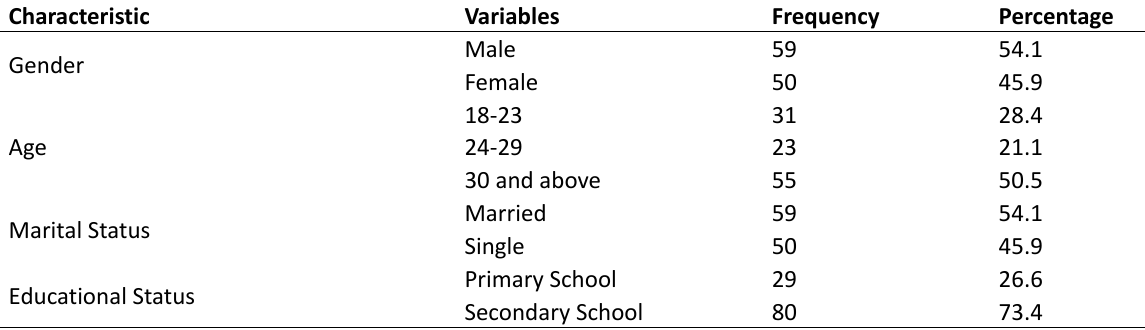
Table 1. Socio-Demographical Characteristics of Participants